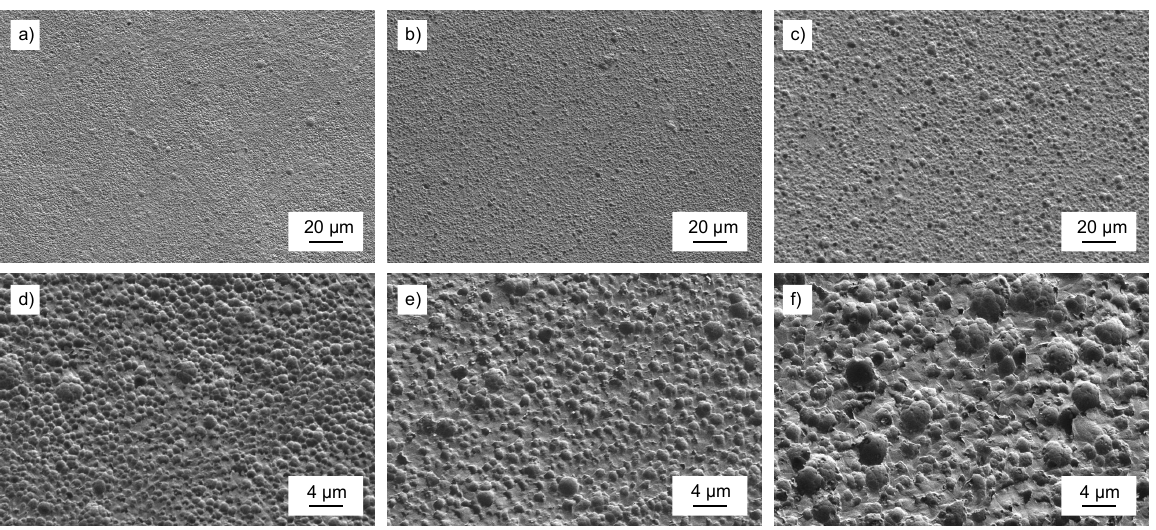
Figure 4. Time-dependent SEM micrographs at different degradation stages of ( a ) PET*24 h, ( b ) PET*48 h, and ( c ) PET*96 h and with higher magnification at ( d ) PET*24 h, ( e ) PET*48 h, and ( f ) PET*96 h.